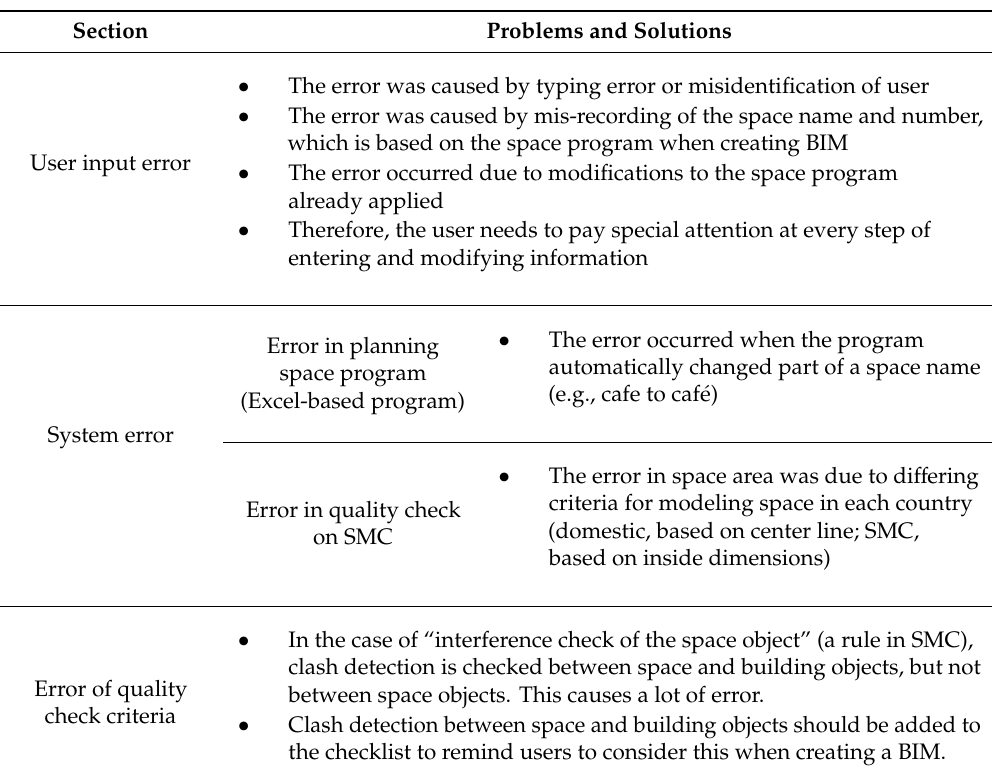
Table 10. Results of quality checking based on space check